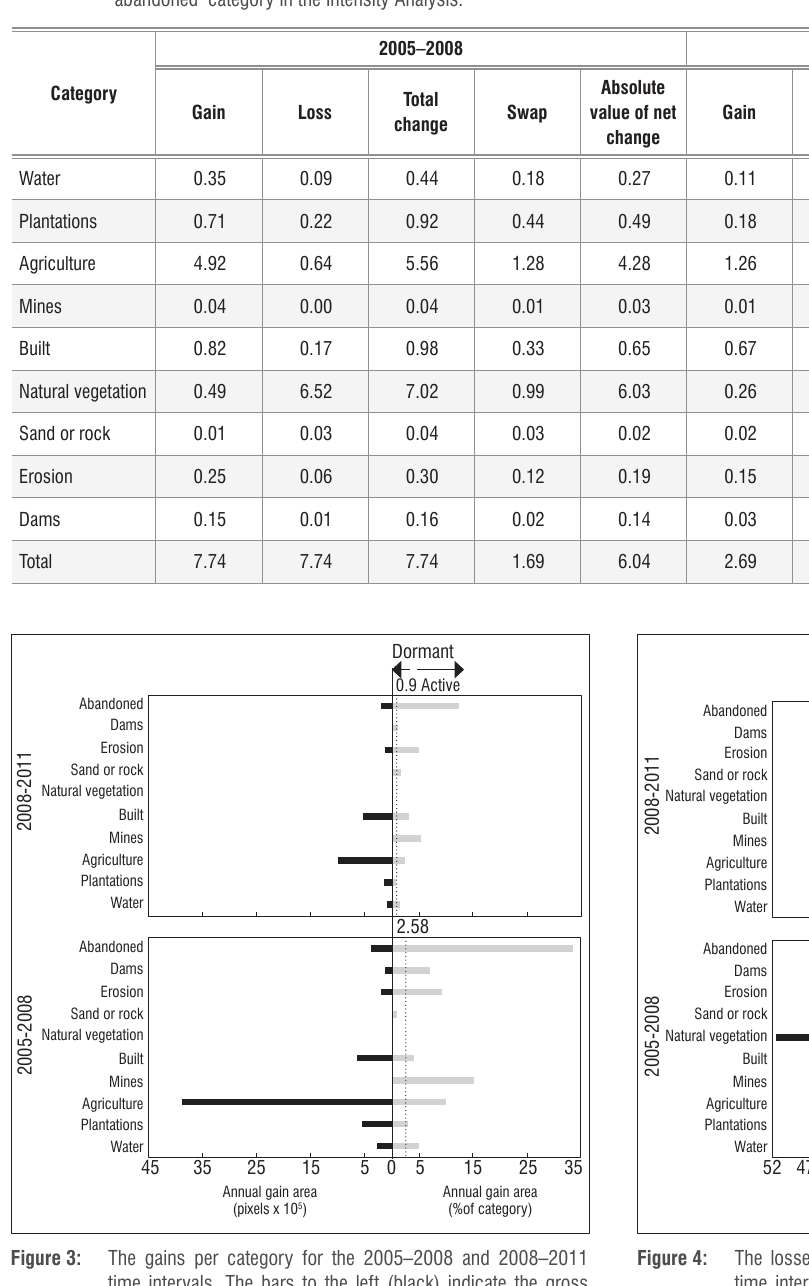
Figure 3: The gains per category for the 2005–2008 and 2008–2011 time intervals. The bars to the left (black) indicate the gross annual area gains per category. The bars to the right (grey) represent the intensity of the annual gains. Grey bars extending to the right or left of the vertical dashed line indicate active or dormant changes, respectively, relative to a uniform intensity across each analysis period.